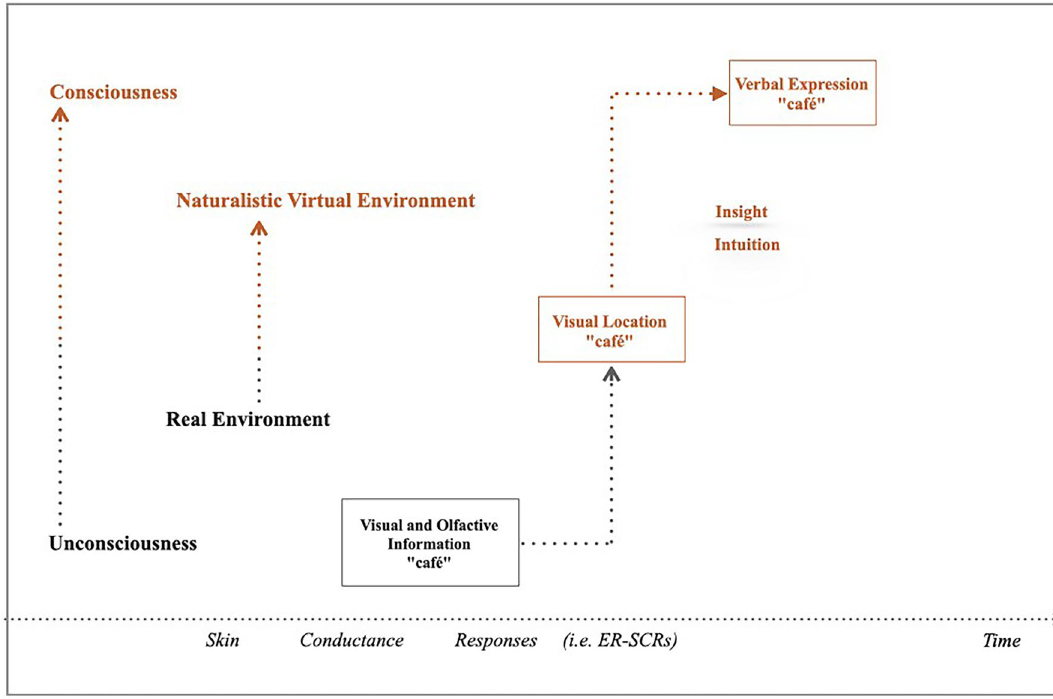
Figure 1. Representation of intuition and insight continuum within real (dark gray colour) and naturalistic virtual (orange colour) environments. Healthy participants were immersed in a real environment which provided visual and olfactive information associated with "café" and "café drink" and the visual location of "café shops" in a naturalistic virtual environment (i.e. a Parisian district). Visual and olfactive information was displayed to engender coherent implicit representations in the real environment, afford continuity and facilitate the emergence of intuition and insight (i.e. euréka) in the virtual environment. Autonomic (unconscious) activity mirrored by related event Skin Conductance Responses were recorded during the whole immersion (both in real and naturalistic virtual environments); verbal (conscious) expressions were considered during the virtual